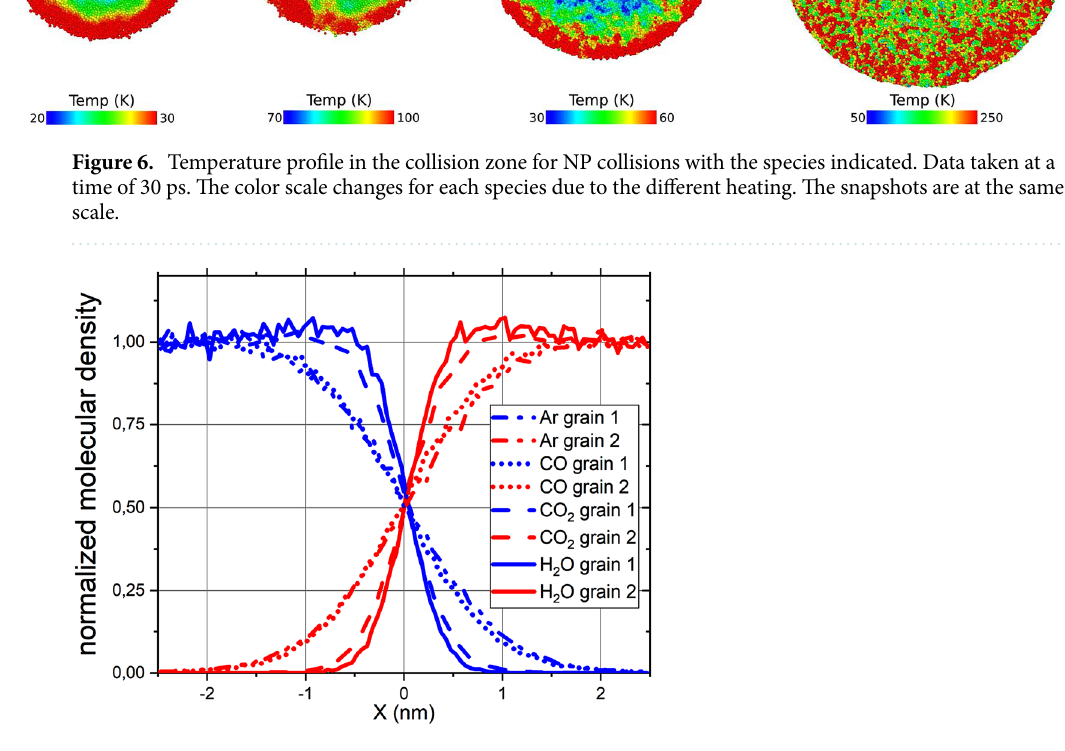
Figure 7. Mixing profiles of the NPs after collision. X measures the distance from the center of mass of the collided clusters, i.e., the center of the collision zone. The ordinate shows the number density of molecules originally affiliated to grain 1 and grain 2, normalized to their original bulk values. The colors denote initial NP affiliation as in Fig.